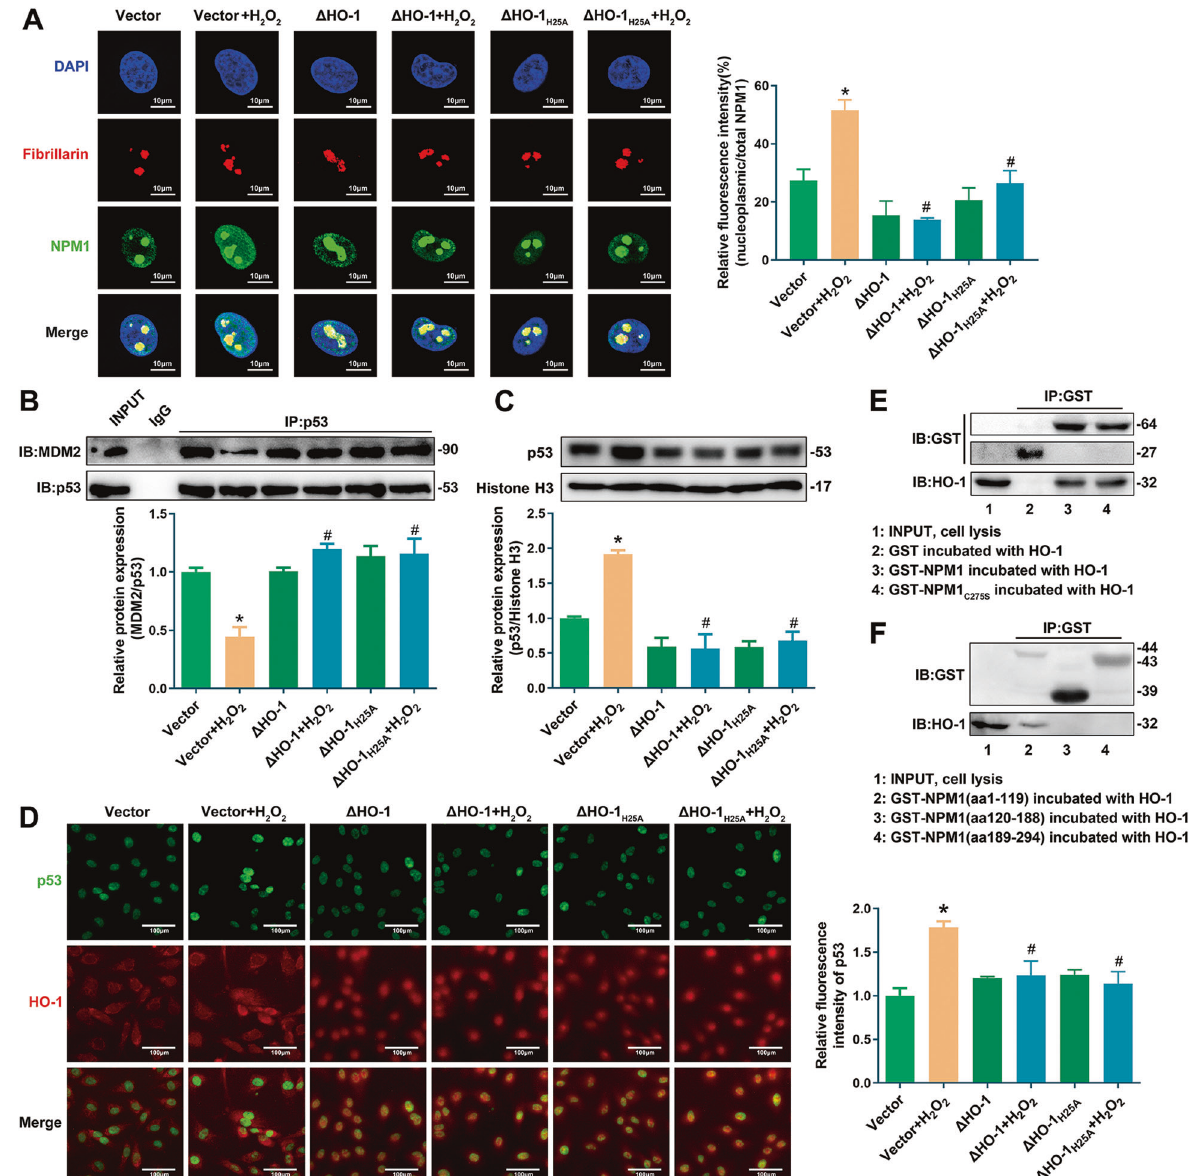
Fig. 6 Nuclear HO-1 inhibited NPM1 translocation and p53 accumulation. A Transfection with Δ HO-1/ Δ HO-1 H25A reversed the increasing n = 3. Fibrillarin, the marker fl uorescence signal of nucleoplasmic NPM1 induced by H * P < 0.05 vs. Vector; and # P < 0.05 vs. Vector + H 2 O 2 . 2 O 2 . of nucleolus. B Transfection with Δ HO-1/ Δ HO-1 H25A reversed the decreasing p53-MDM2 interaction induced by H 2 O 2 . * P < 0.05 vs. Vector; and n = 3. C , D Transfection with Δ HO-1/ Δ HO-1 # P < 0.05 vs. Vector + H * P < 2 O 2 . H25A reversed the up-regulation of nuclear p53 induced by H 2 O 2 . 0.05 vs. Vector; and # P < 0.05 vs. Vector + H 2 O 2 . n = 3. E Identi fi cation of the interaction between HO-1 and GST-NPM1 or GST-NPM1 C275S . n = 5. F Identi fi cation of the interaction between HO-1 and truncated NPM1 domains. n =